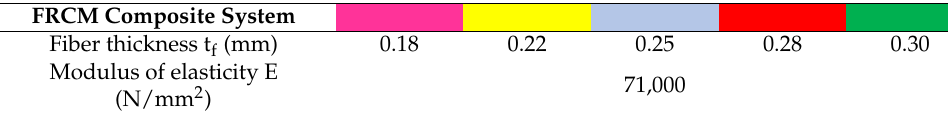
Table 5. FRCM composite system